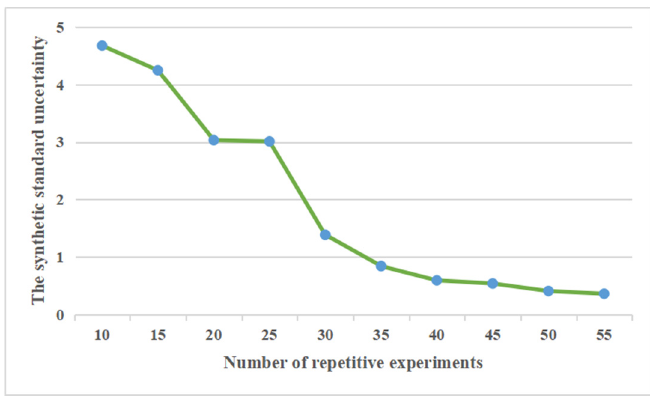
Figure 22. The synthetic standard uncertainty.